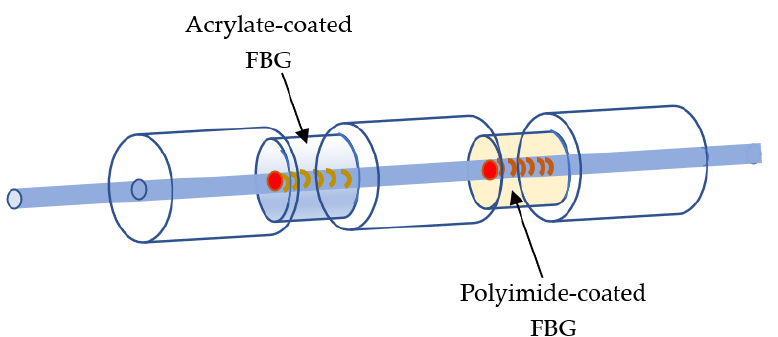
Figure 4. Schematic of the designed humidity sensor.